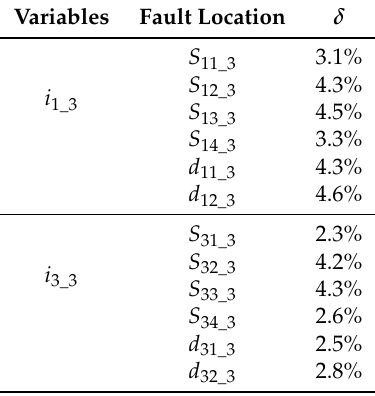
Table 7. Relative error of phase current with open-circuit fault.